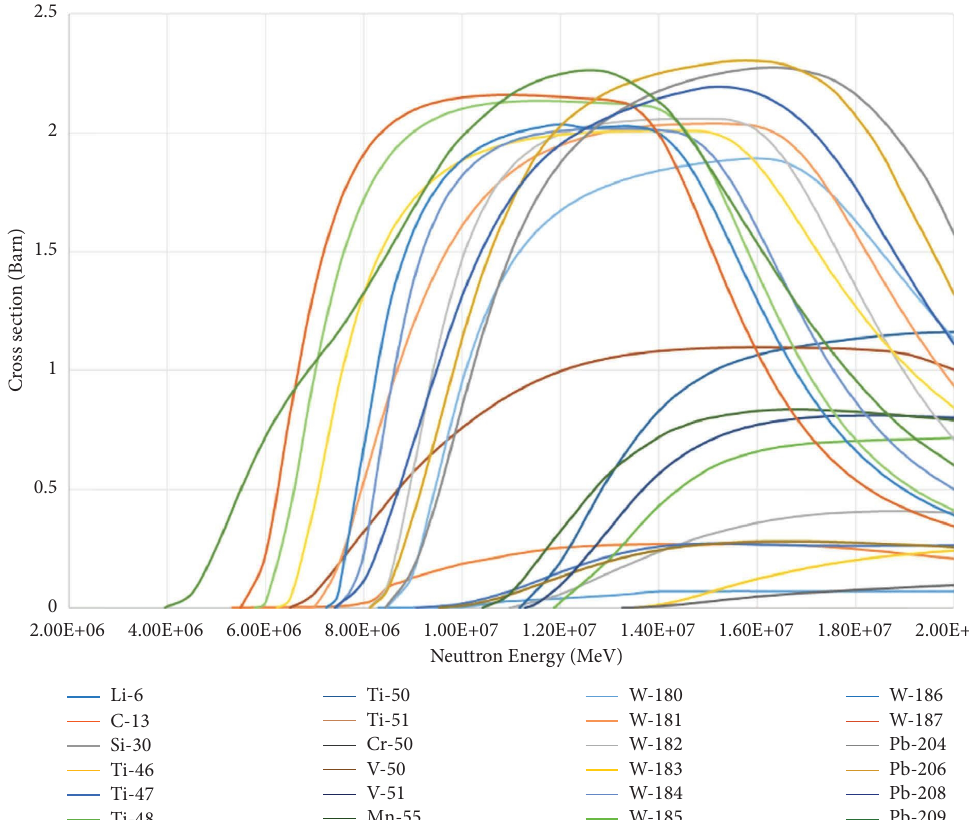
Figure 6: Cross-section of reaction ( n , 2 n ) in every element related to the material of FW by using ENDF/B-VII.1 [33]. Geometry design